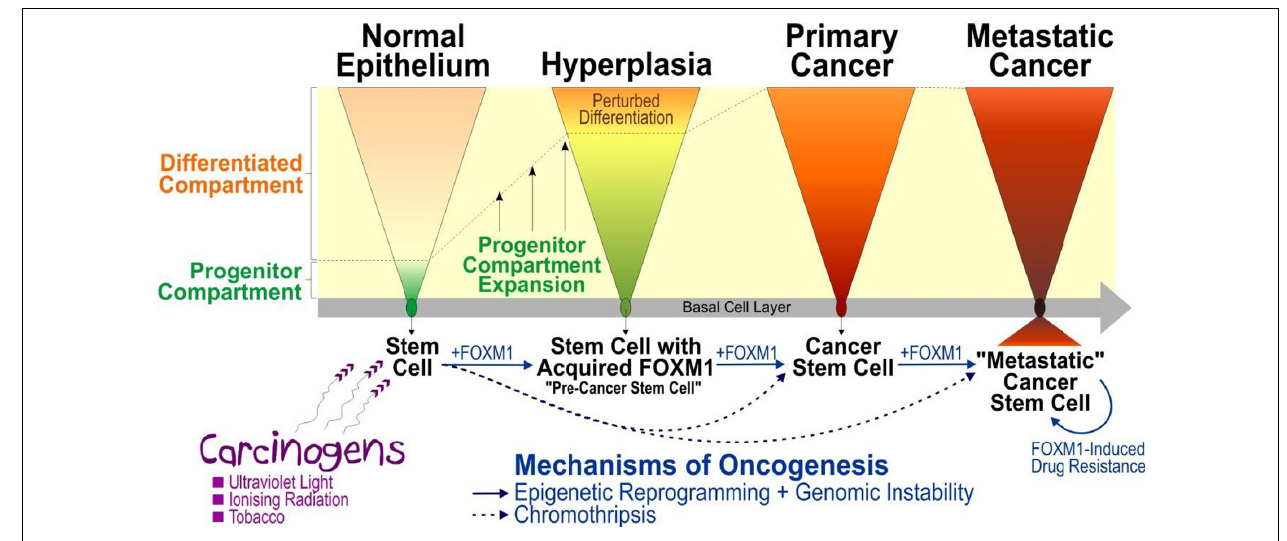
mutations thereby driving oncogenic progression and subsequent metastatic invasion. Due to the complexity of genomic instability and epigenetic reprograming activated by FOXM1, this model may explain the heterogeneity found in tumor whereby the initial molecularly distinct “pre-cancer stem cells” undergo constant adaptive evolutionary changes to produce “cancer stem cells” and subsequently “metastatic cancer stem cells” during the course of cancer progression. An alternative mechanism involving catastrophic genomic rearrangement, chromothripsis, has been shown to produce tumor directly and rapidly from normal cells without the need for sequential accumulation of oncogenic mutations (Liu etal., 2011; Stephens etal., 2011; Crasta etal.,